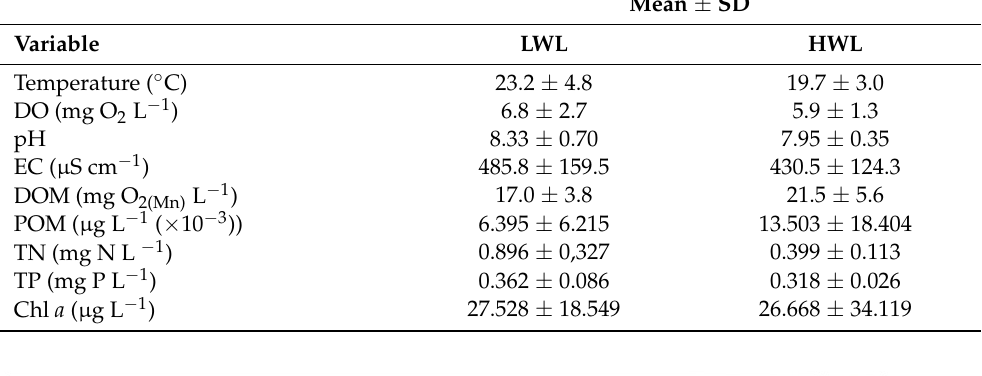
Table 1. Mean and standard deviation (SD) of the physicochemical parameters during the study period. Temperature—water temperature; DO—dissolved oxygen concentration; EC—electrical conductivity; DOM—dissolved organic matter; POM—particulate organic matter; TN—total nitrogen concentration; TP—total phosphorous concentration; Chl a —chlorophyll concentration. Mean ± SD